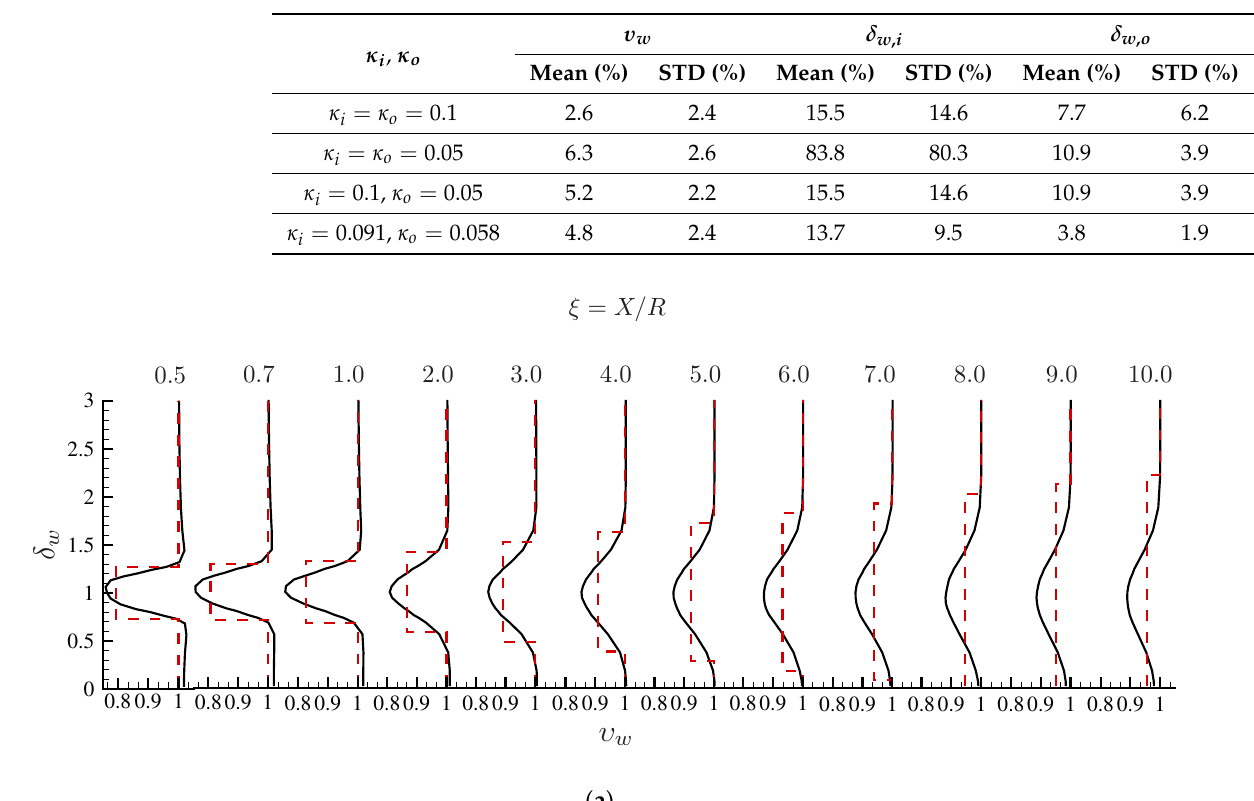
Table 1. Comparison between analytical and CFD results, where the mean and standard deviation of the relative difference between the two sets of results are given.